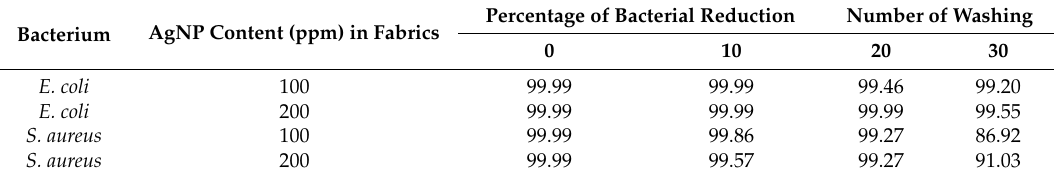
Table 1. Bacterial reduction percentages of PVP-AgNP/nylon nanocomposite fabrics against E. coli and S. aureus . Reproduced from [134] with permission of Elsevier.